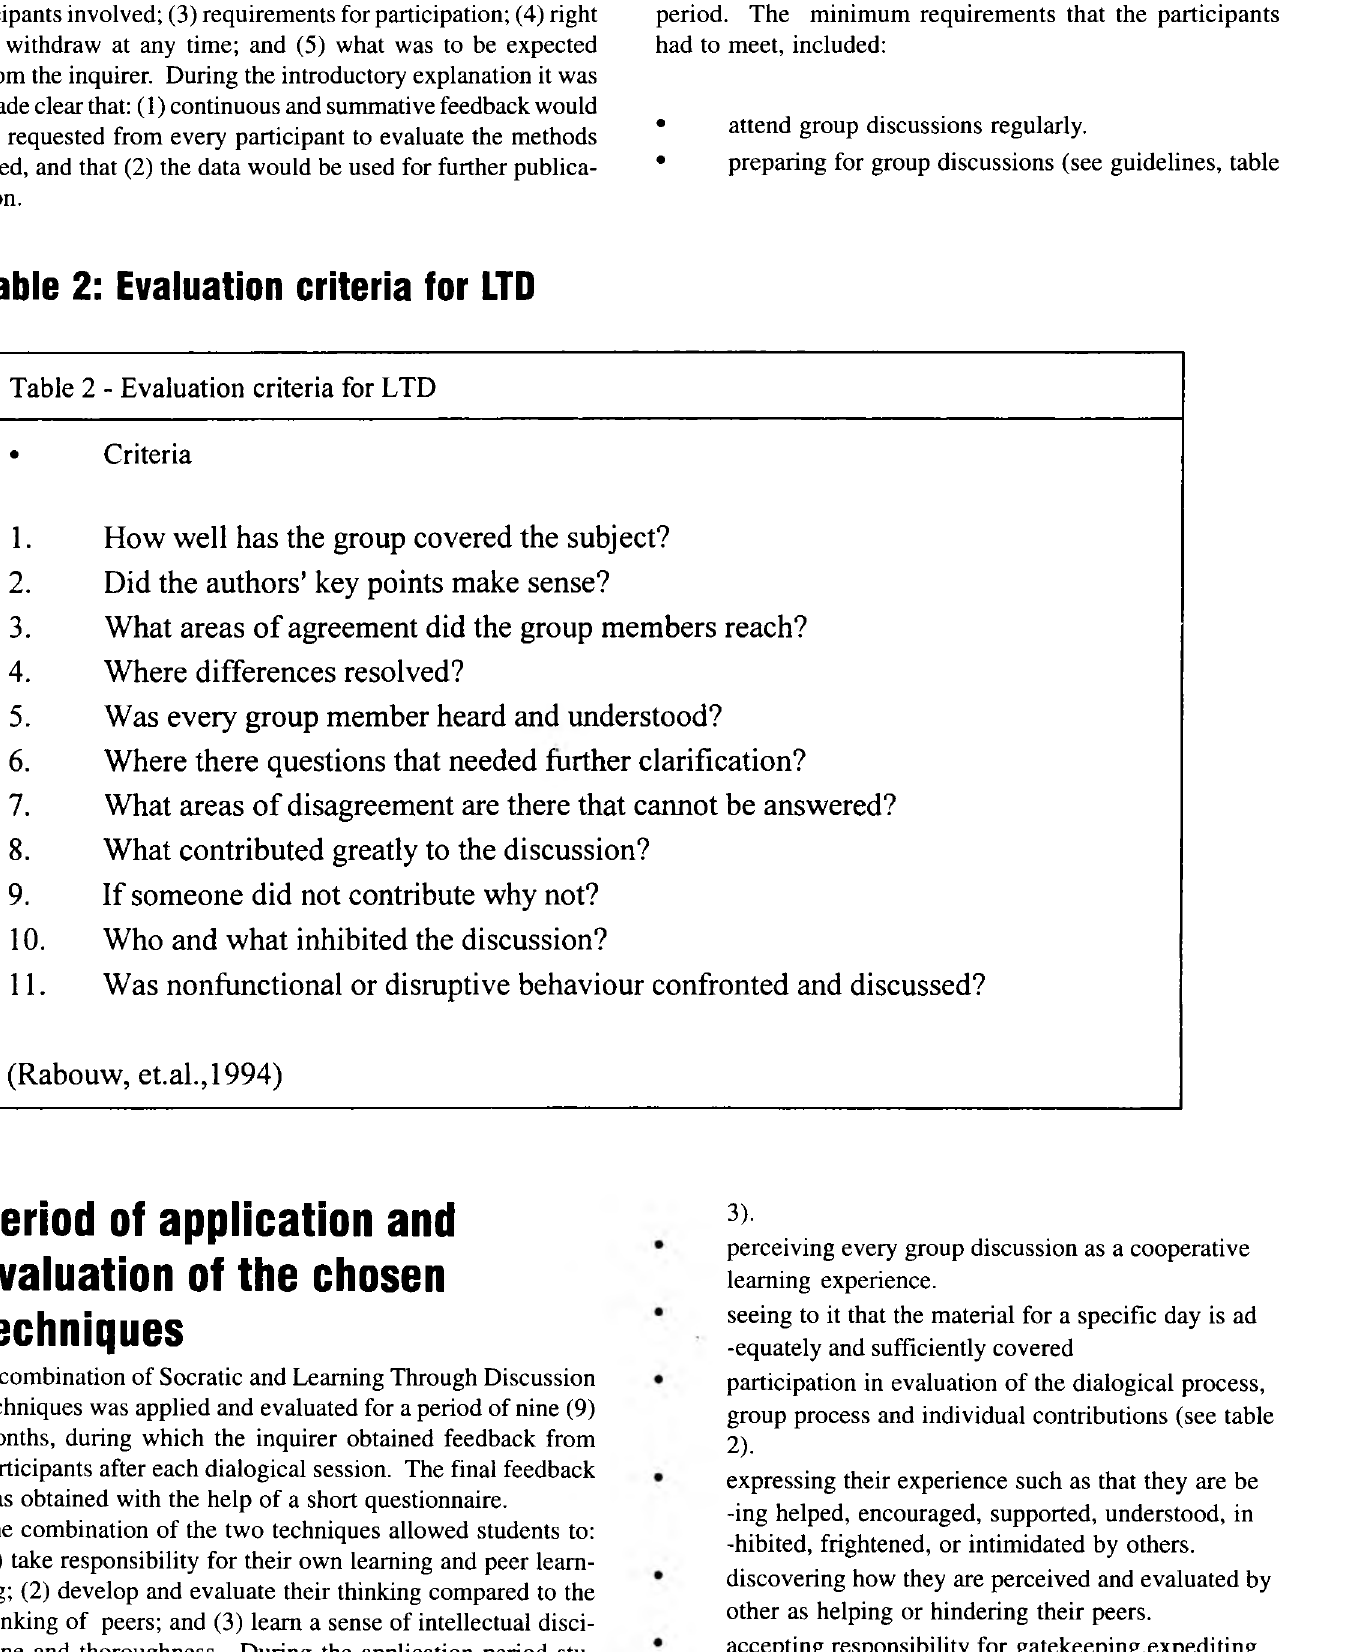
Table 2: Evaluation criteria for LTD Table 2 - Evaluation criteria for